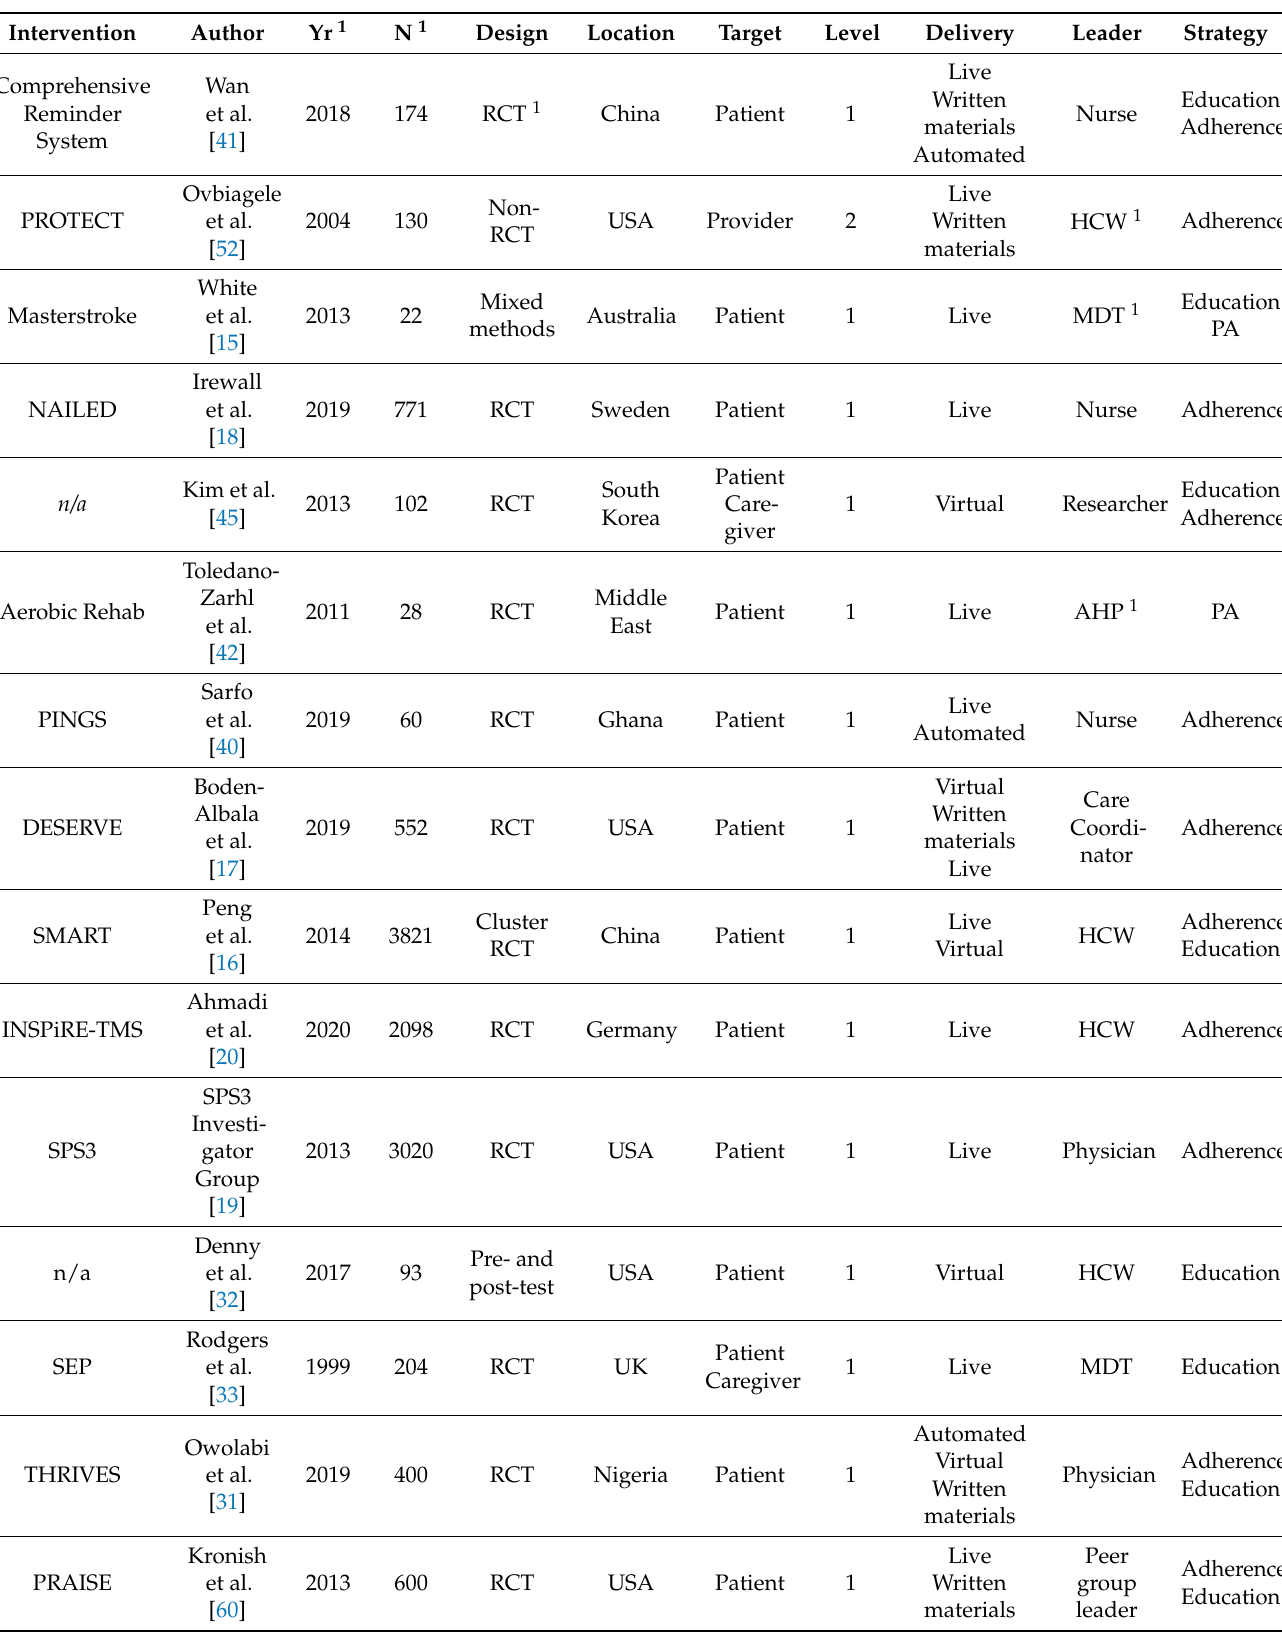
Table 4. Summary of Basic Study